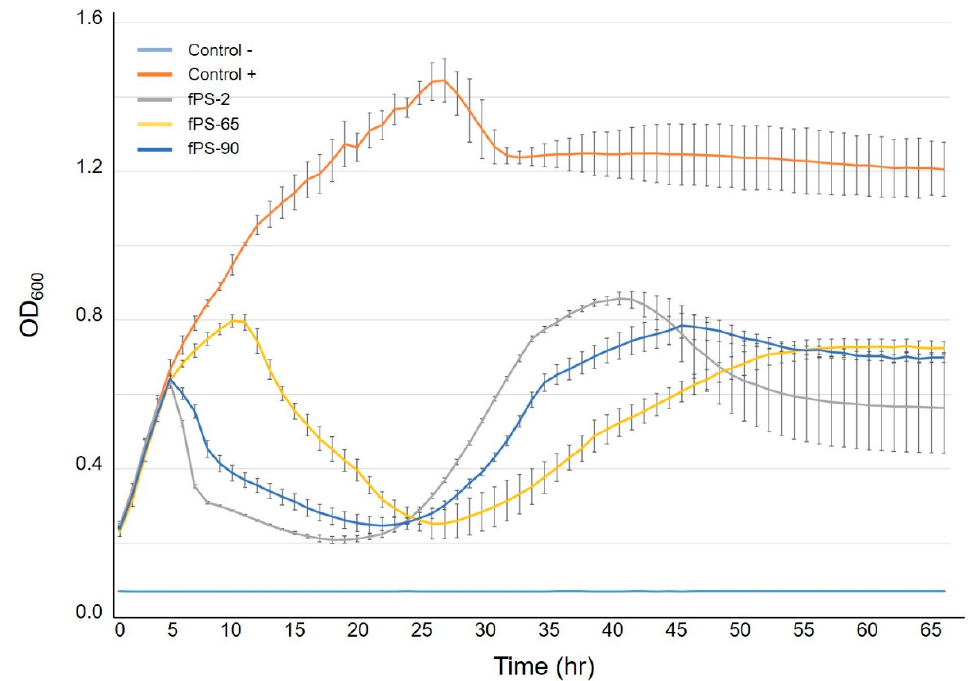
Figure 5. Growth curves of Y. pseudotuberculosis O:1a strain PB1 infected with phages fPS-2, fPS-65 and fPS-90 at a MOI of 0.001. Each curve represents the average results for five replicates. Error bars represent standard deviation (SD).